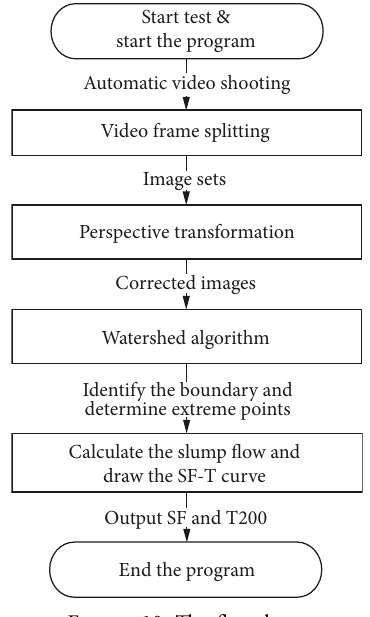
Figure 10: The flowchart. Table 1: Comparison of SF measurement results of cement paste flowability